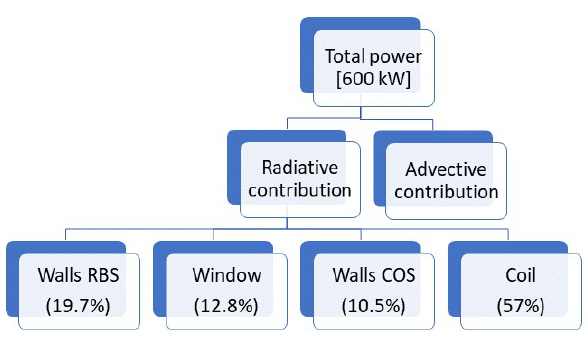
Figure 17. Energy budget of the coil coating